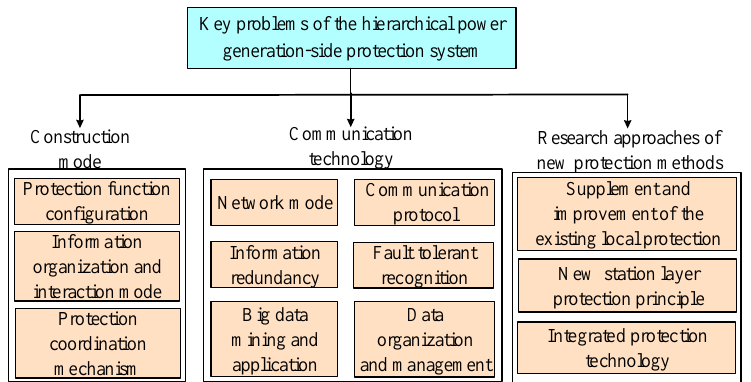
Figure 14. Key problems of the hierarchical power generation-side protection